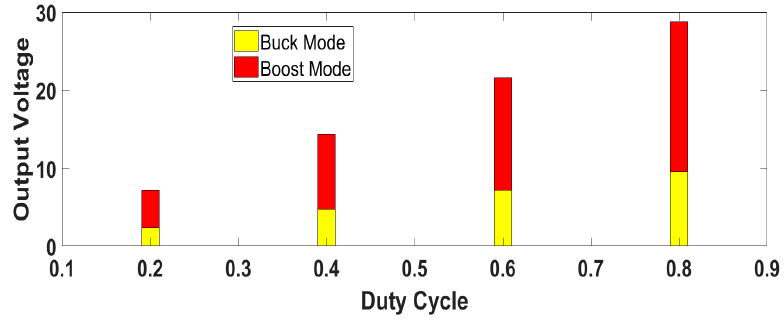
Figure 22. Experimental DC–DC converter voltage comparison of buck mode and boost mode with a boost factor of 2.